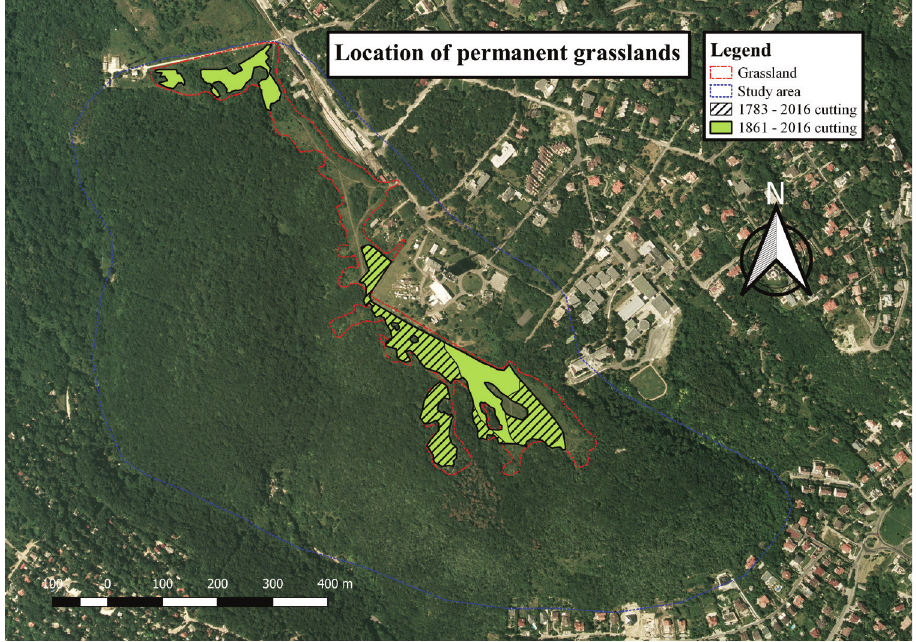
Figure 4. Presumed location of permanent grasslands on the Széchenyi Hill,